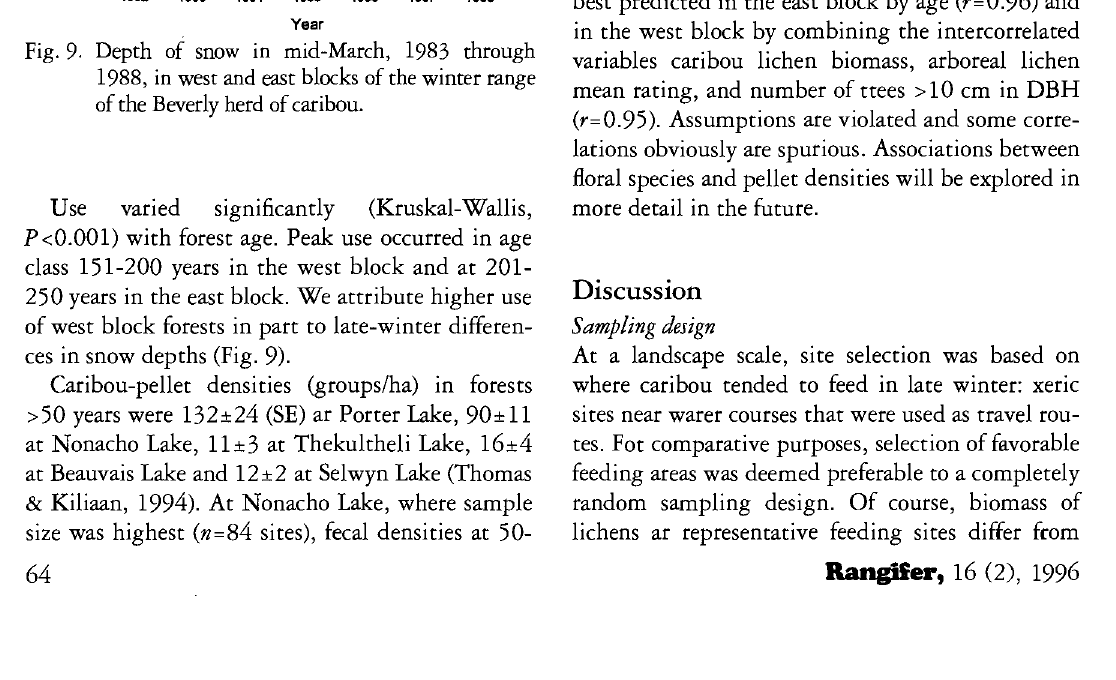
Fig. 9- Depth of snow in mid-March, 1983 through 1988, in west and east blocks of the winter range of the Beverly herd of